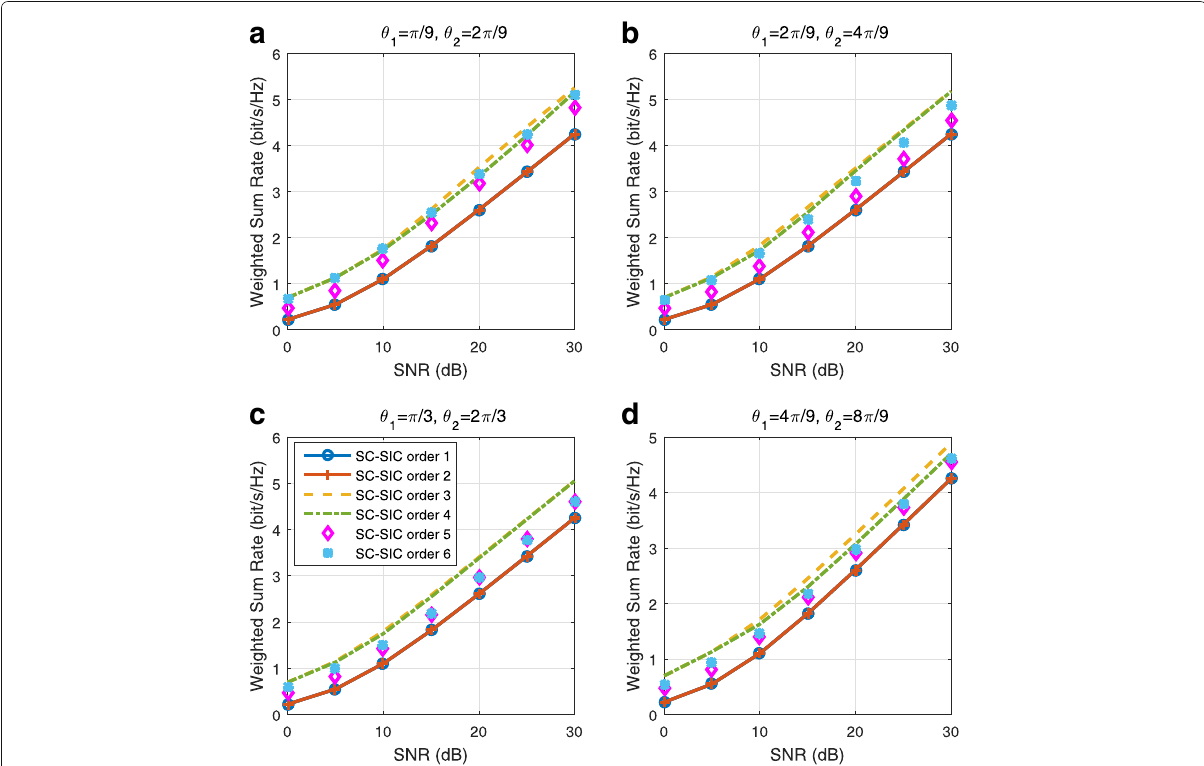
Fig. 15 Weighted sum rate versus SNR comparison of different decoding order of SC–SIC for underloaded three-user deployment with perfect CSIT, = 1, γ = 0.3, u = 0.2, u = 0.3, u = 0.5, N = 4, R th = 0, k ∈ { 1,2,3 } . a θ γ 1 2 1 2 3 t k d θ 1 = 4 π/ 9, θ 2 = 8 π/